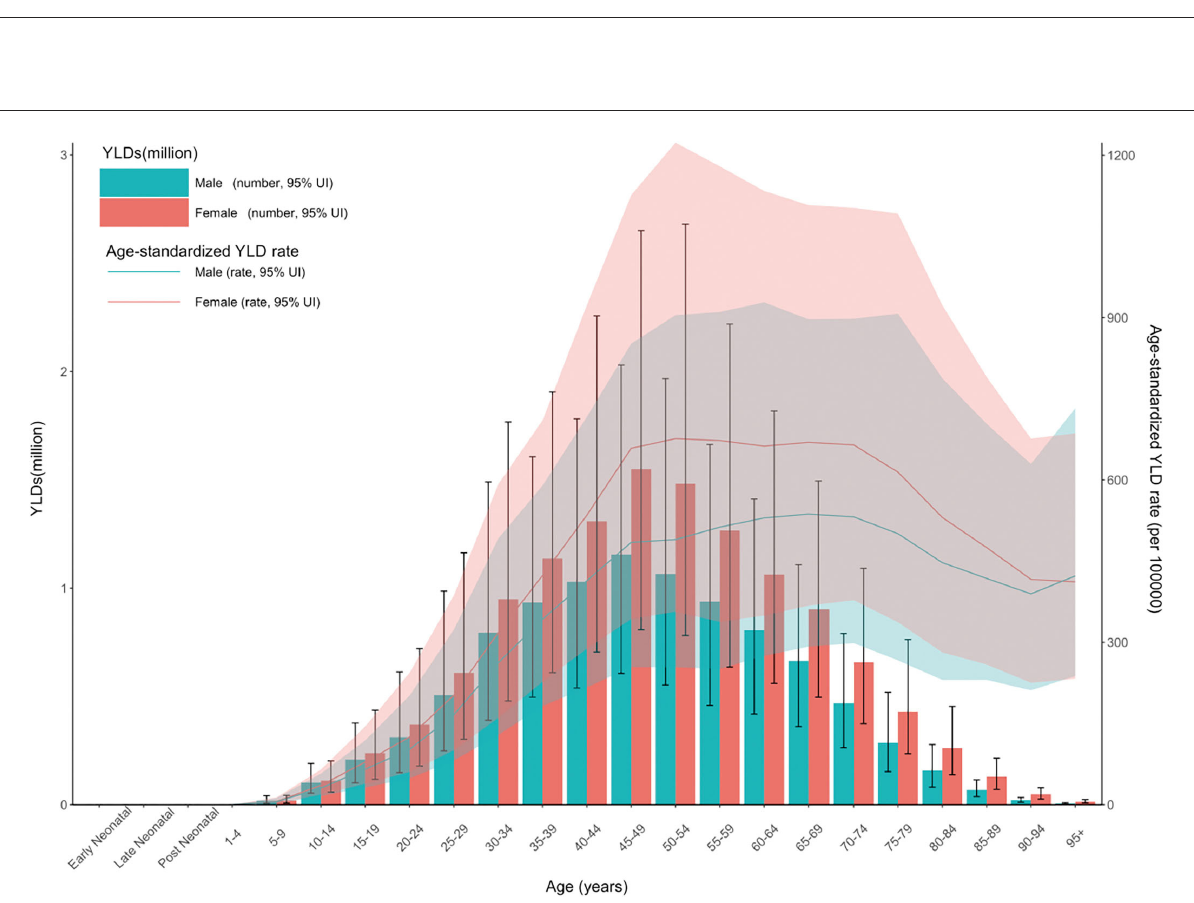
FIGURE1 Age-standardized point YLD of neck pain per 100,000 population in 2019 by country. Generated from data available at http://ghdx.healthdata. org/gbd-results-tool. DALY, disability-adjusted life years.